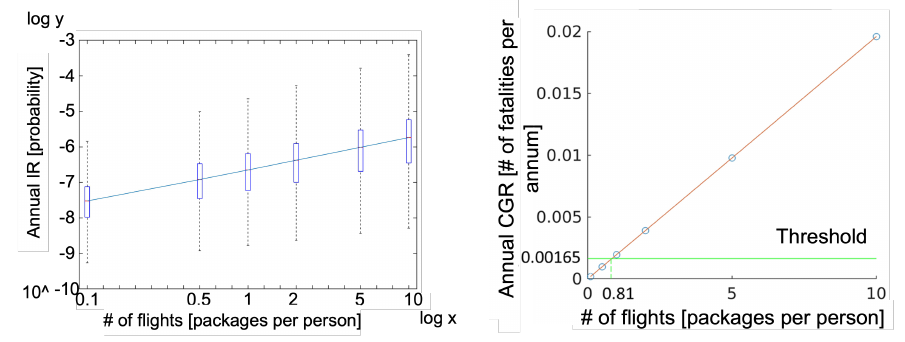
Figure 8. Annual IR and annual CGR with different flight